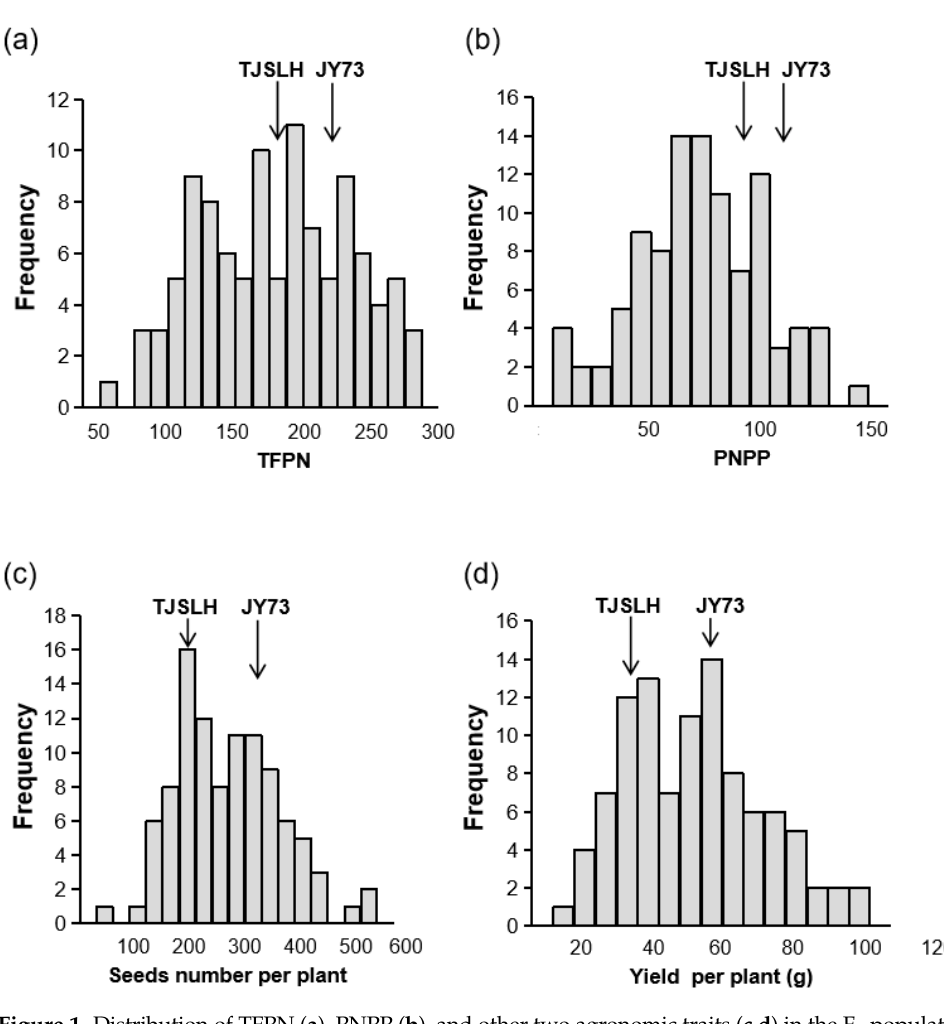
Figure 1. Distribution of TFPN ( a ), PNPP ( b ), and other two agronomic traits ( c , d ) in the F 2 popula- tion.